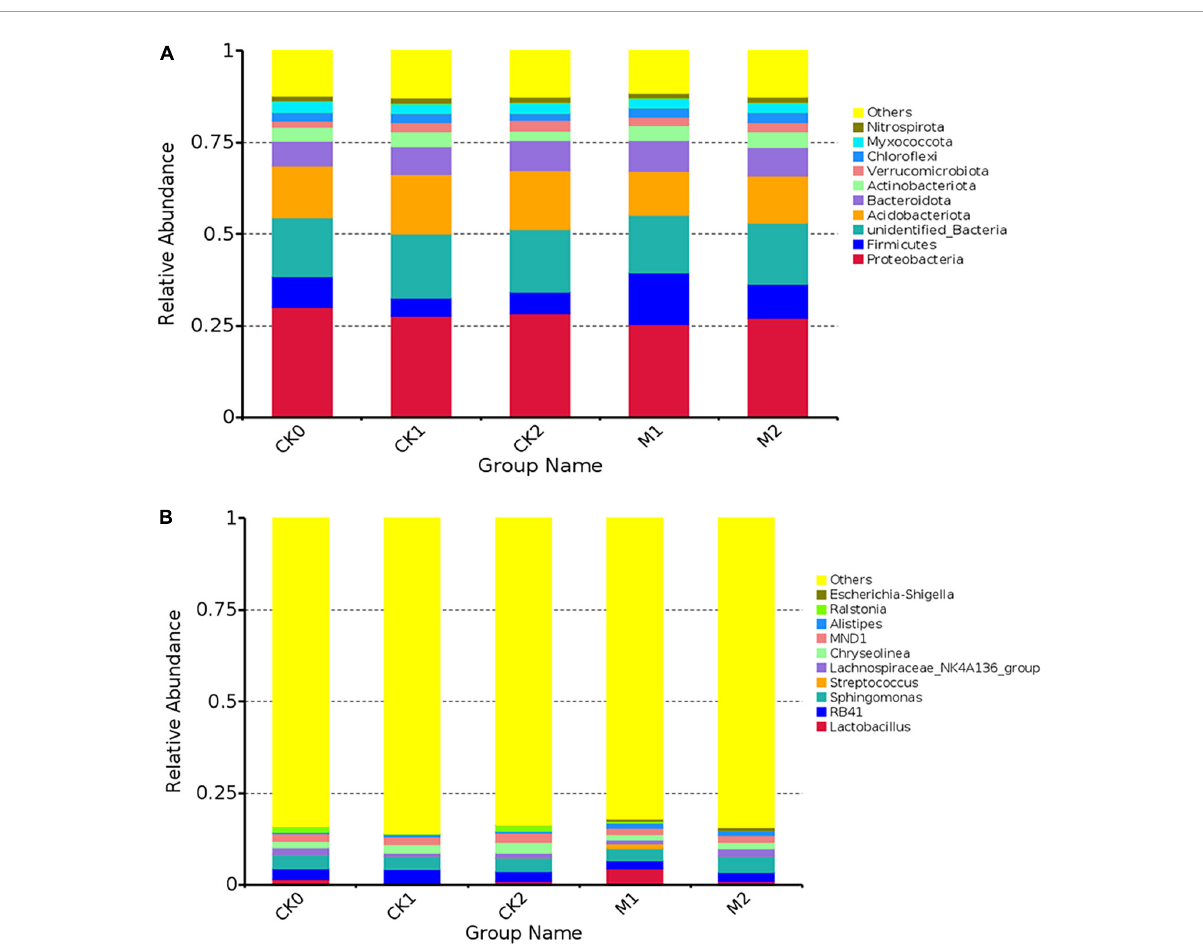
FIGURE2 The composition of bacterial communities at the phylum level (A) and genus level (B) in the five types of samples. The 10 species with the highest abundance at each level were selected for each sample type. “Others” represents of the sum of the relative abundance of all other phyla (genus) other than these 10 phyla or